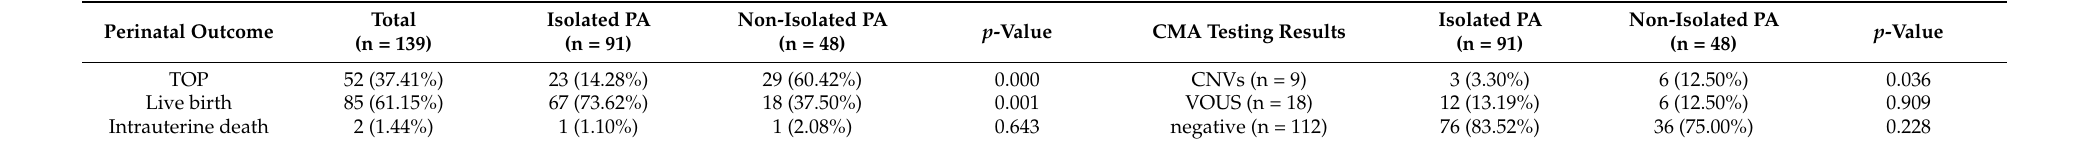
Table 3. Statistical analysis of the genetic results and perinatal outcomes of PA